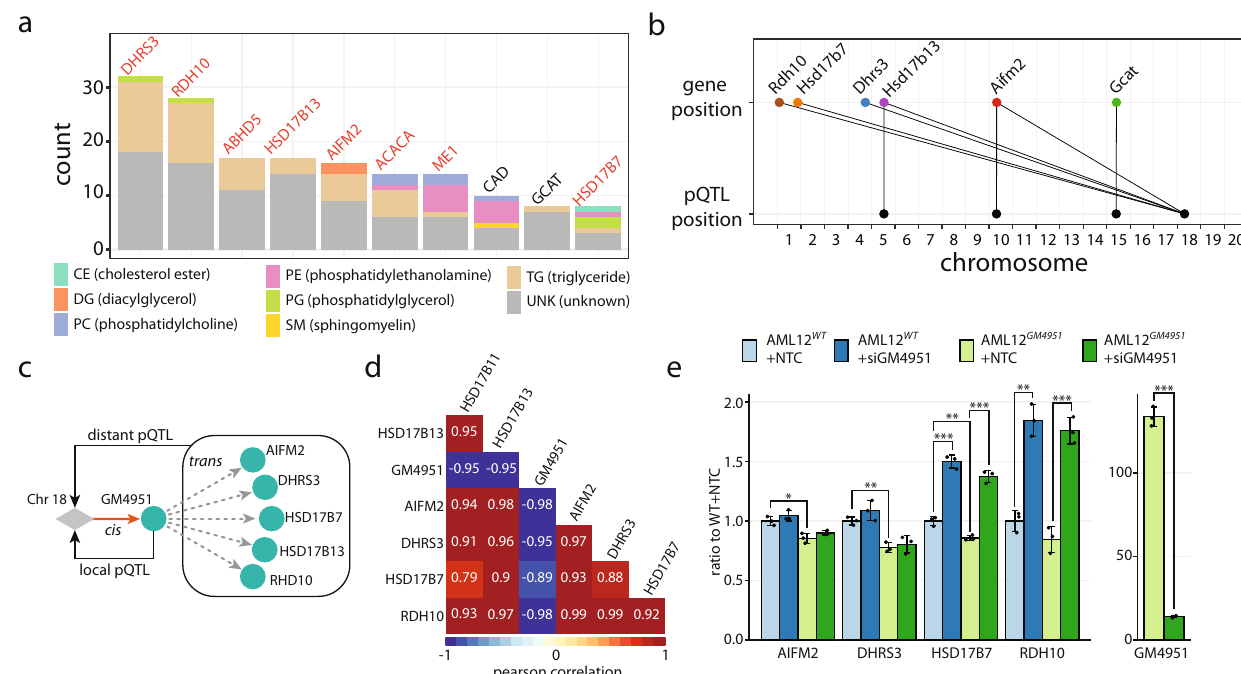
Fig.7|MediationoflipidQTLrevealsakeyregulatorforlipiddroplets. Thefour GoDig analyses targeting 220 proteins across 480 mouse livers were combined. Each protein was evaluated as a potential mediator of QTL for 2,269 lipids in the liversfromLinkeetal.Mediationresultswere fi lteredusinganLODscorereduction >50% and z-score< − 4. Resulting protein-lipid pairs were considered as being co- regulated. a BarchartrepresentingthenumberoflipidsfromLinkeetal.withwhich each protein is co-regulated. The top 10 proteins are shown. Proteins known to have lipid droplet localization are in red text. Lipids are colored based on cate- gories. b GeneandpQTLpositionsofthetop6proteinswiththemostco-regulated lipids and identi fi ed pQTL. Five proteins (AIFM2, DHRS3, HSD17B7, HSD17B13 and RHD10) have a distant pQTL mapping to a hotspot on chromosome 18 at 60 Mbp.